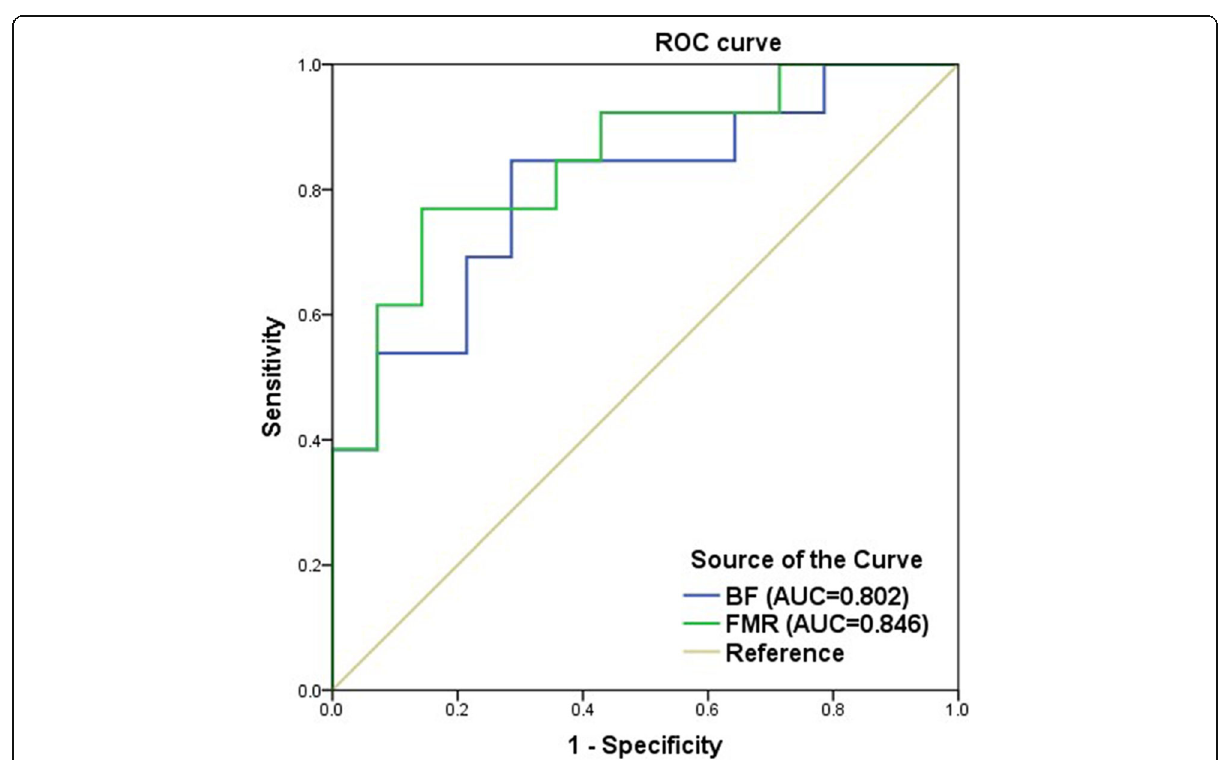
Fig. 2 The AUCs of FMR and BF were 0.846 (95% CI 0.656-0.955; p = 0.002) and 0.802 (95% CI 0.605-0.929; p = 0.008). Comparison of ROC